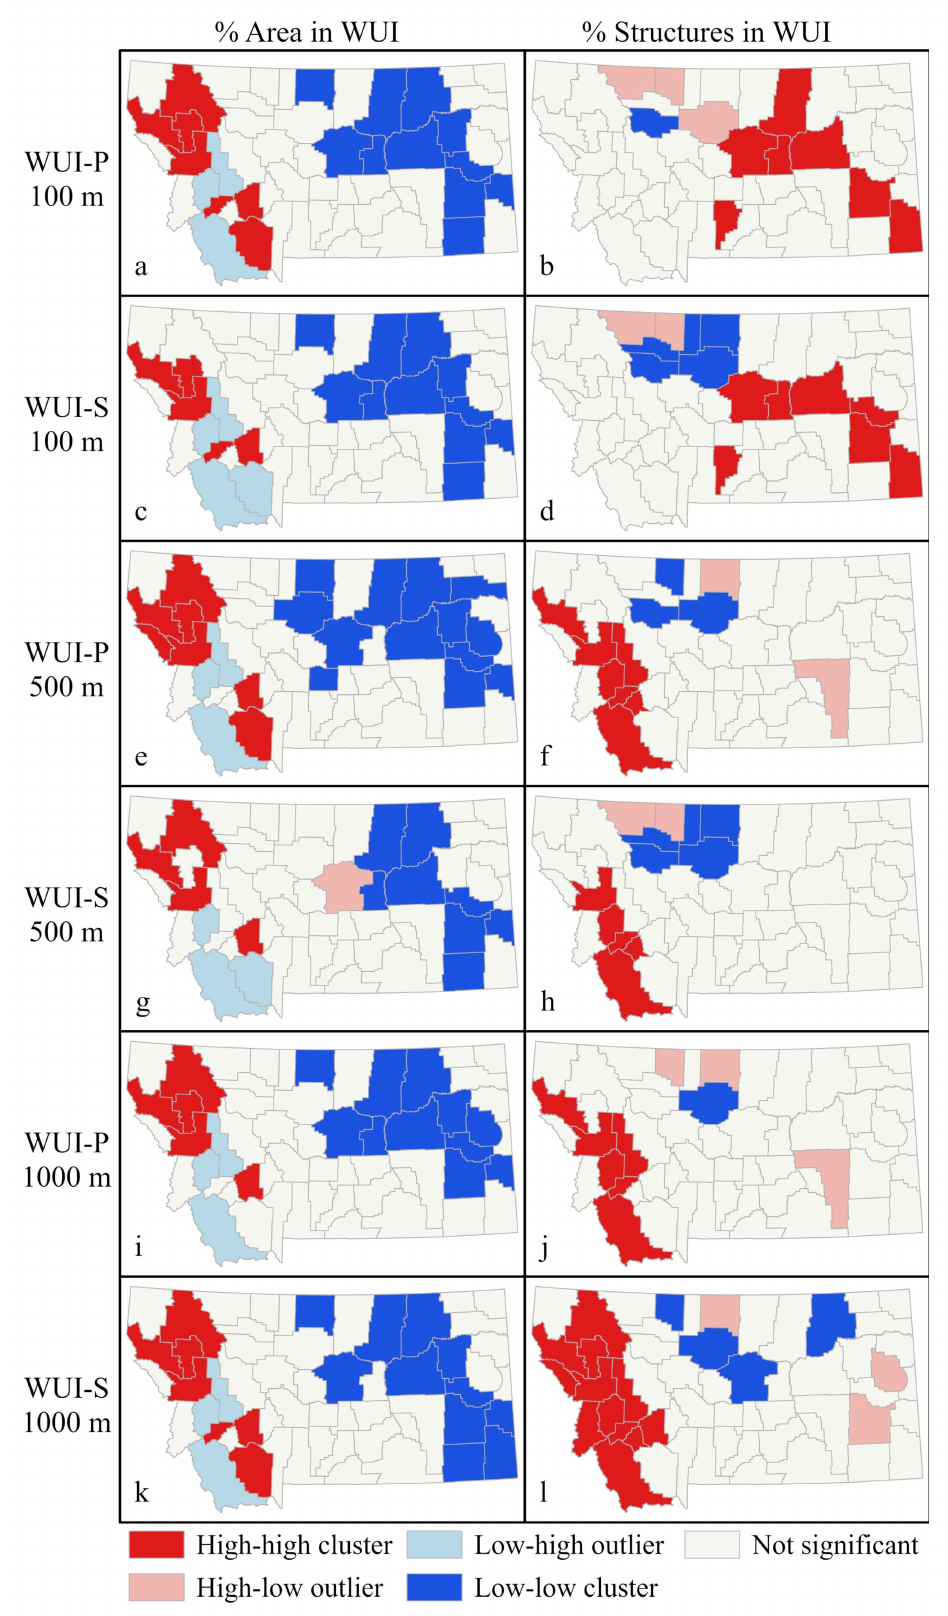
Figure 9. The local Moran’s I results for WUI-P and WUI-S at 100 m ( a – d ), 500 m ( e – h ), and 1000 m ( i – l ) buffer